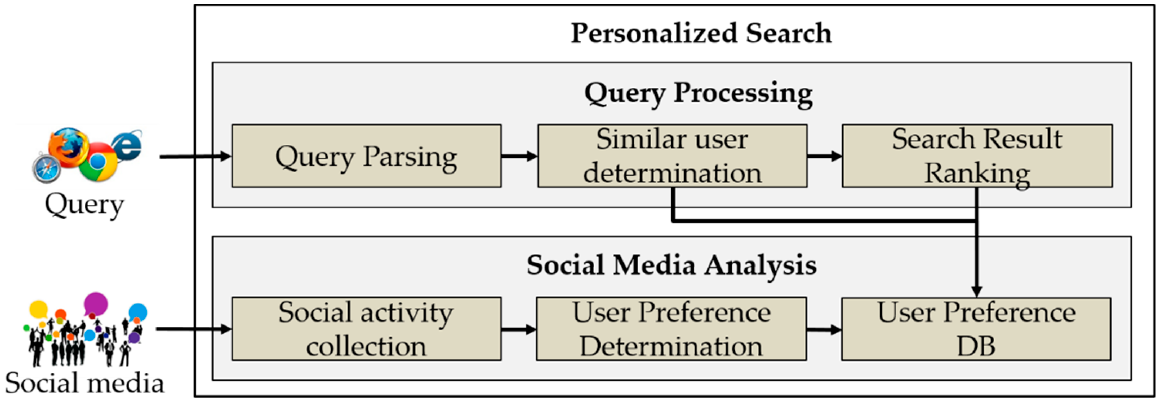
Figure 1. Overall architecture of the proposed search method.